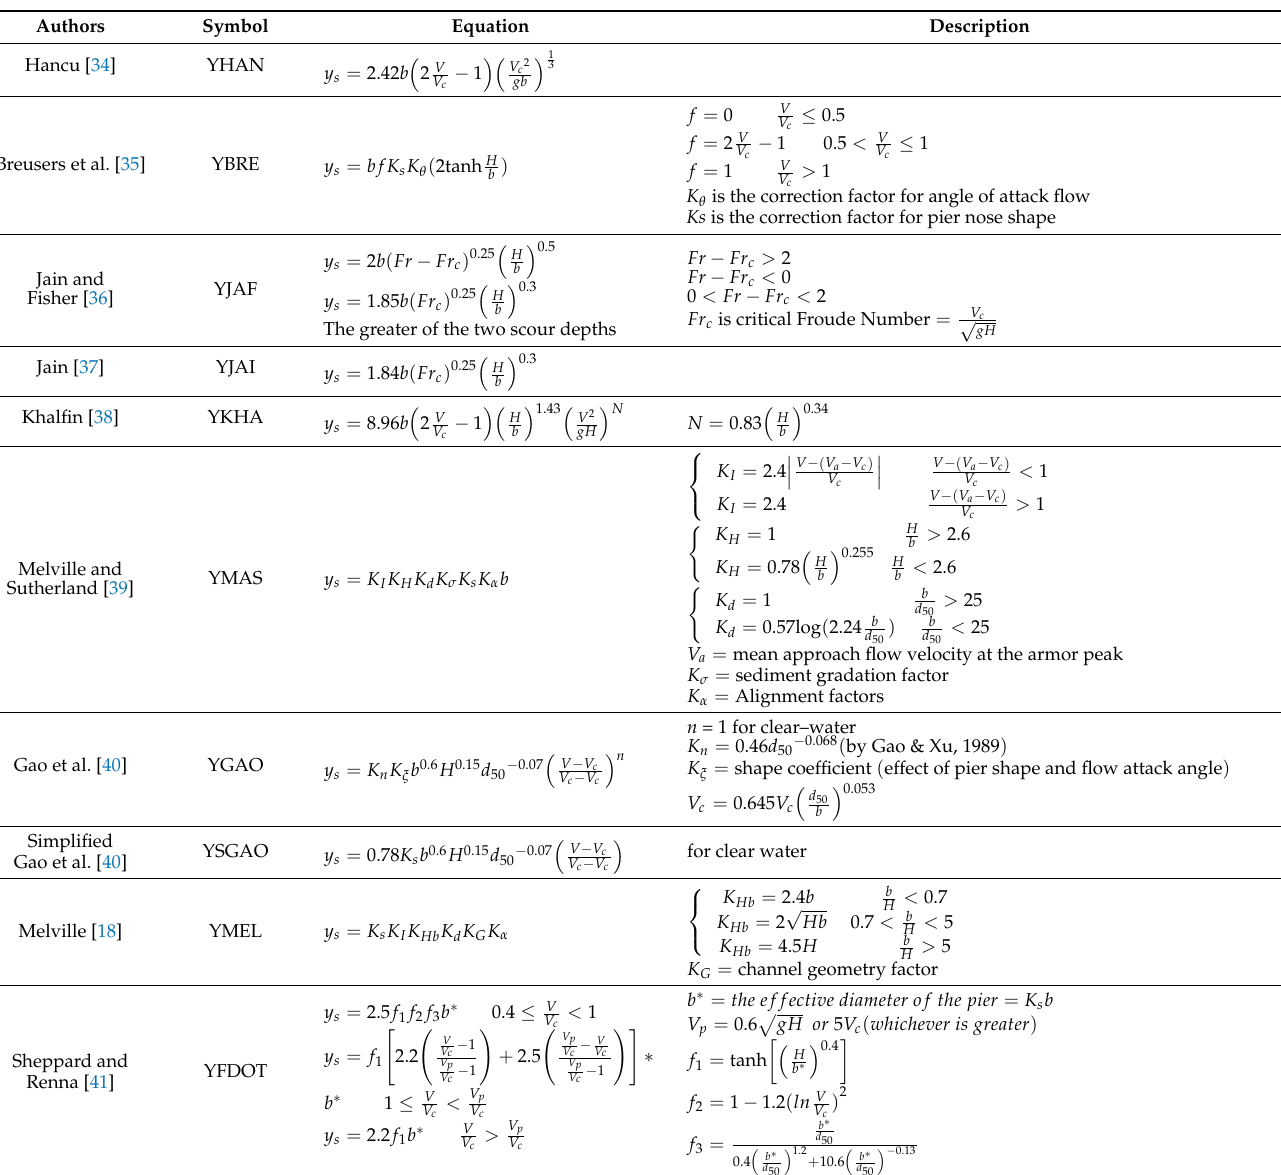
Table 1. Scour depth prediction